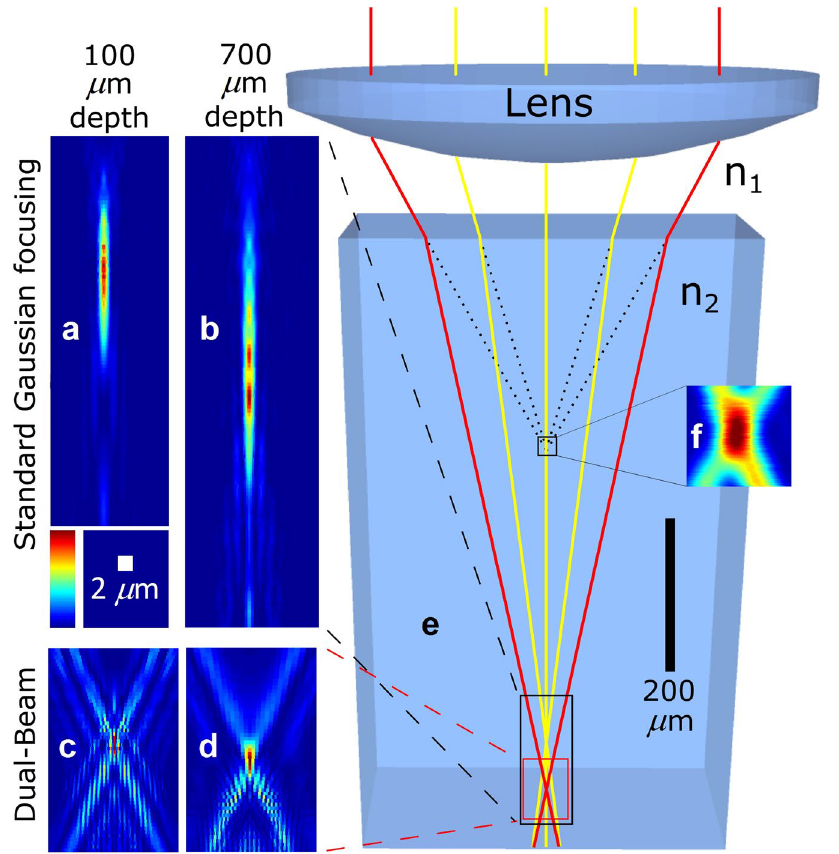
Figure 3. The Dual-Beam technique strongly reduces the spatial aberration at the focus. The simulated intensity profile of the focal spot is elongated when focused in a sample using a standard focusing method (at 100 μ m depth, ( a ), and at 700 μ m depth, ( b )) while it remains similar using the Dual-Beam technique with φ = 19°, θ = 4° (( c ) and ( d )). ( e ) The colored Zemax simulation shows the ray tracing in the sample ( n focused with a 0.55 NA lens at a depth of 700 μ m. The red rays represent the Dual-Beam technique. ( f ) Experimental measurement of the focus intensity profile in air n 1 = 1 (see Methods for more information). The 2 μ m scale bar is valid for ( a ) to ( d